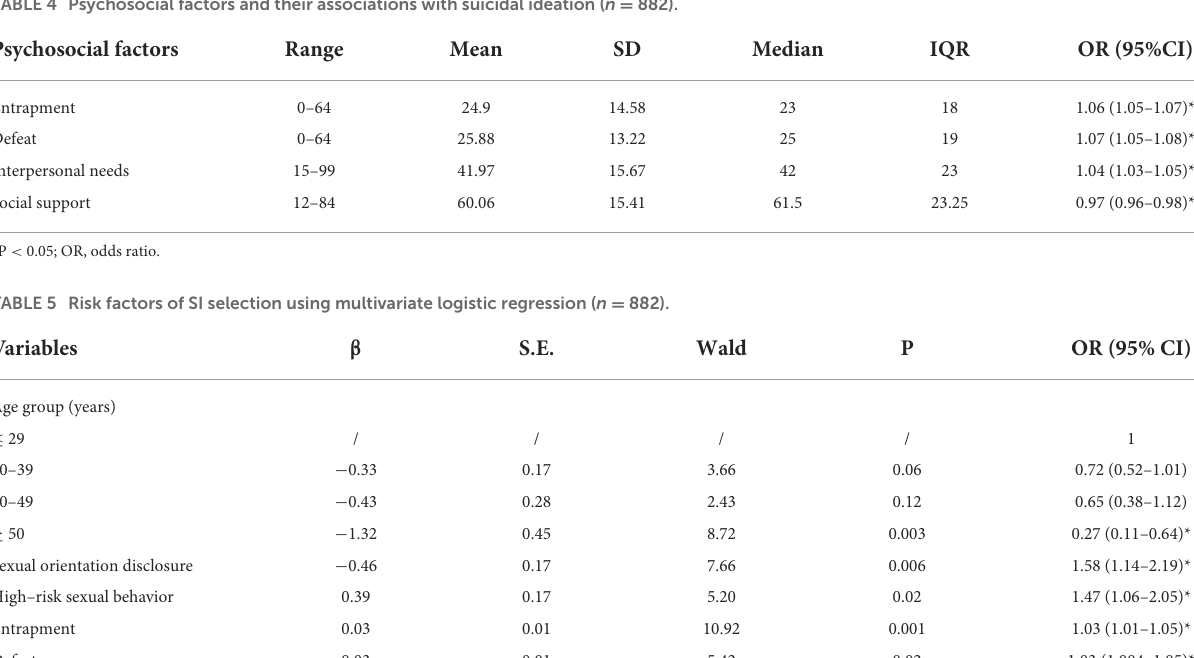
TABLE 4 Psychosocial factors and their associations with suicidal ideation ( n = 882).